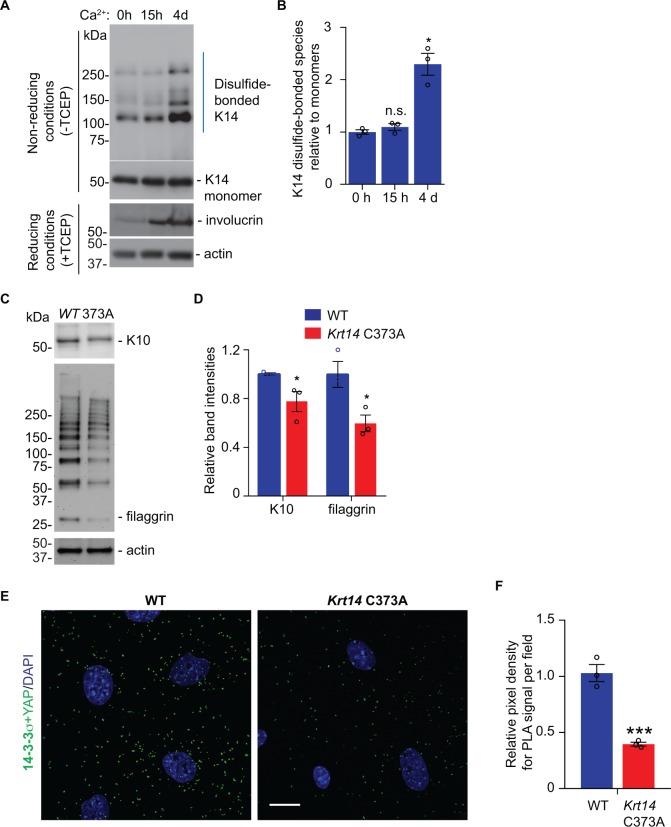
Additional analyses of newborn skin keratinocytes in primary culture.(A) Western blot analysis of total protein extracts from WT newborn keratinocytes in primary culture, in the absence (0 hr) and presence of calcium for 15 hr and 4 days (4d) after addition of calcium. Gels were run is the absence or presence of TCEP reduction as indicated at left. This analysis shows the kinetics of formation of K14-dependent disulfide species after adding calcium. Involucrin is shown as a marker of terminal keratinocyte differentiation; actin is used as a loading control. (B) Quantification (gel scanning densitometry) of the gel data shown in frame A. Data represent mean ± SEM from N = 3 biological replicates. (C) Western blot analysis comparing the steady state levels of K10 and filaggrin at 4 days after adding calcium to primary cultures of WT and Krt14 C373A newborn keratinocytes in primary culture. Filaggrin presents as a gallery of discrete size products consistent with its modular repeat substructure. (D) Quantification (gel scanning densitometry) of the gel data shown in frame C. Data represent mean ± SEM from N = 3 biological replicates. (E) Proximity ligation assays (PLA) for 14-3-3σ and YAP1 in WT and Krt14 C373A newborn keratinocytes in primary cultures subjected to 1 mM calcium-induced differentiation for 4 days. Bar = 20 µm. Nuclei are stained with DAPI (blue). (F) Quantitation of the data shown in frame E. N = 42 cell we counted for each genotype. Data represent mean ± SEM. Student’s t test: ***p<0.005; n.s., no difference.